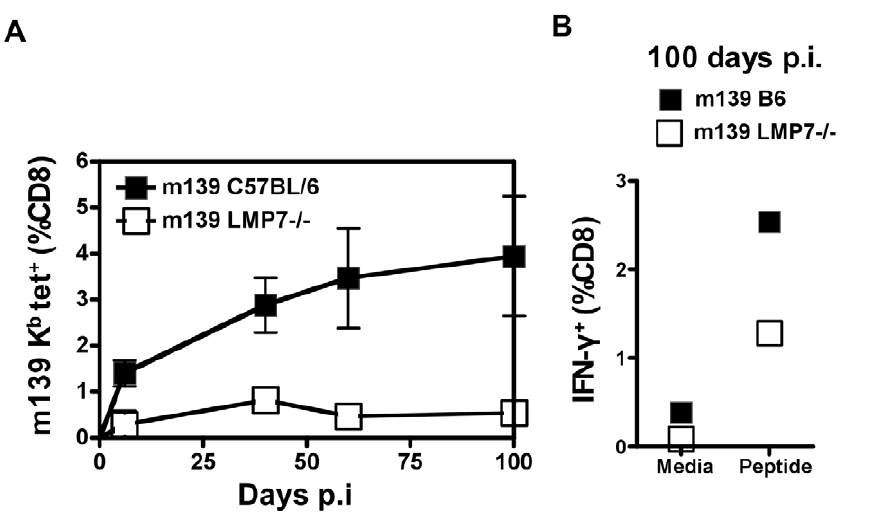
Figure 3. CD8 + T cell response to inflating epitope m139 in LMP7 2 / 2 mice infected with MCMV. A. Lymphocytes were prepared from the peripheral blood of LMP7 2 / 2 and C57BL/6 control mice 7 days p.i. (n=3) or PBS (n=2) and subjected to tetramer stain and FACS analysis as for Figure 1A, using MCMV m139 tetramer (H-2 K b 419 TWYGFCLL 426 ). This epitope has been shown to elicit a CD8 + T cell response that increases over time, or inflates, in C57BL/6 mice. The plot shows the frequency of m139 K b -specific cells among CD8 + T cells over a 100 day time course. B.